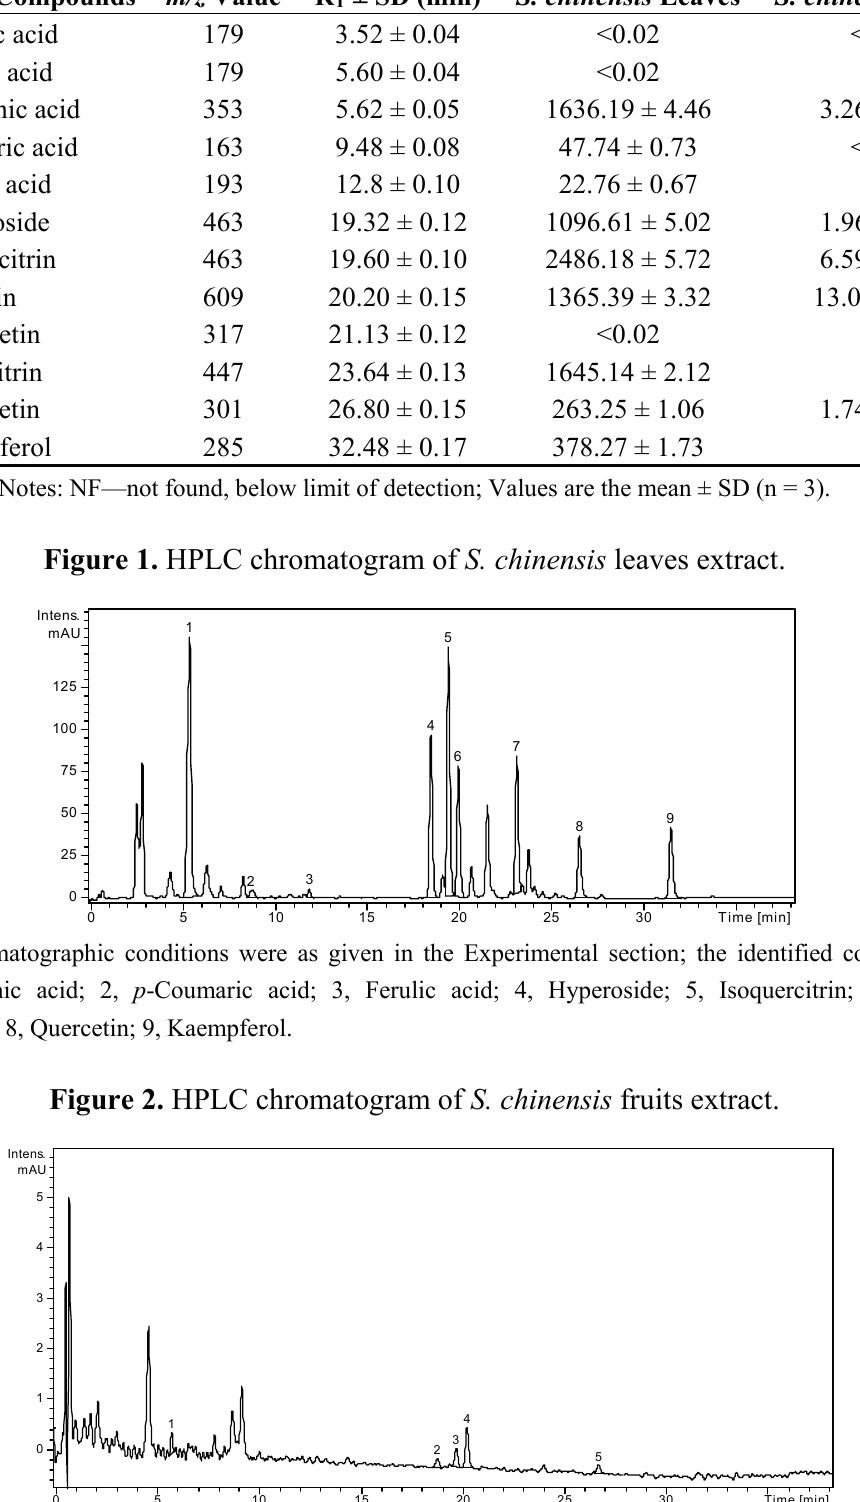
Table 1. The polyphenolic compounds content in the natural products ( μ g/g plant material). Polyphenolic Compounds